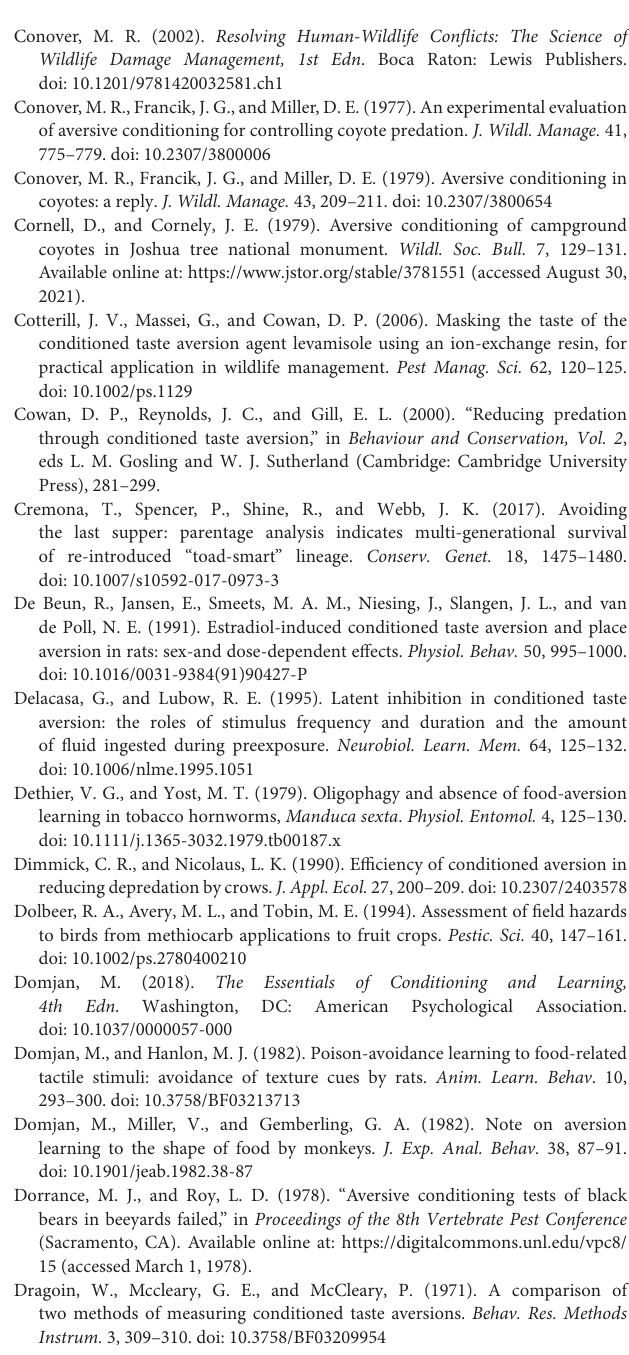
Supplementary Table 1 | Web of Science search string. Supplementary Table 2 | Scopus search